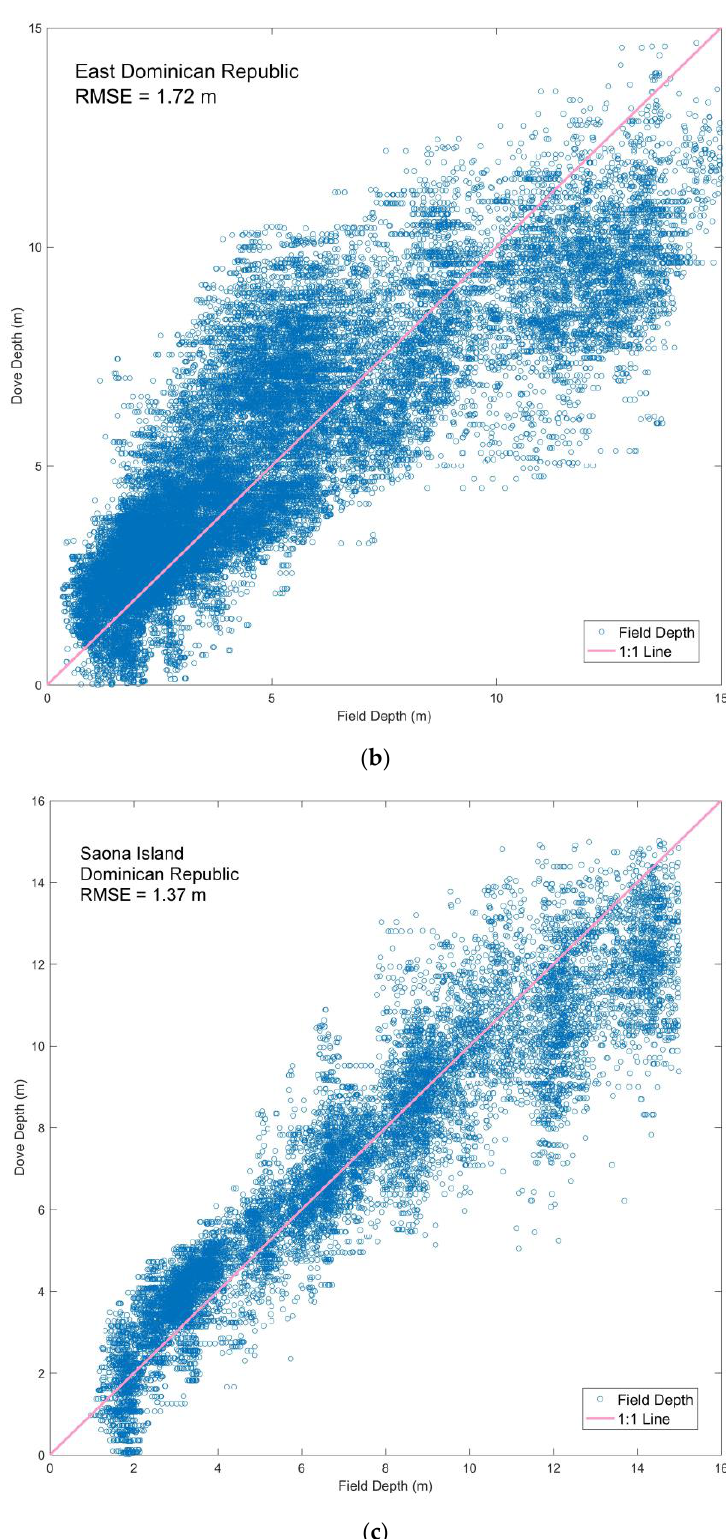
Figure A1. ( a ) Satellite derived bathymetry validation at Catalina Island, Dominican Republic. ( b ) Satellite derived bathymetry validation at east Dominican Republic. ( c ) Satellite derived bathymetry validation at Saona Island, Dominican